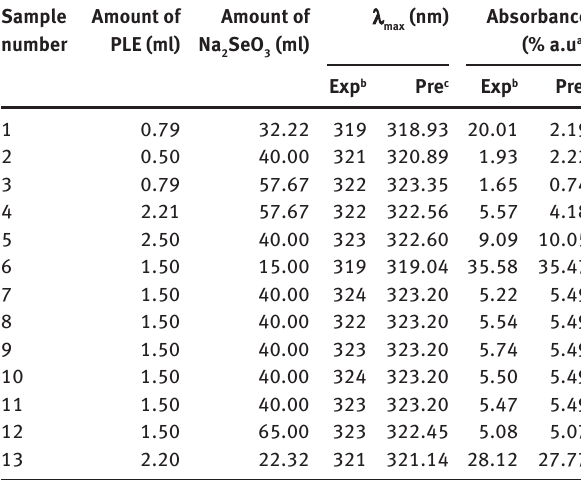
Table 1: Experimental runs according to the central composite design (CCD) for selenium nanoparticles (Se NPs)